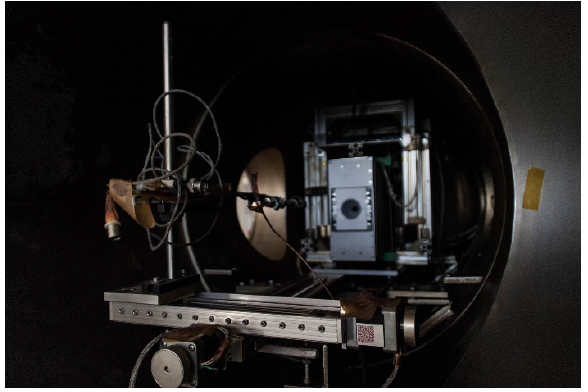
Figure 7. Setup of the Environmental Test.